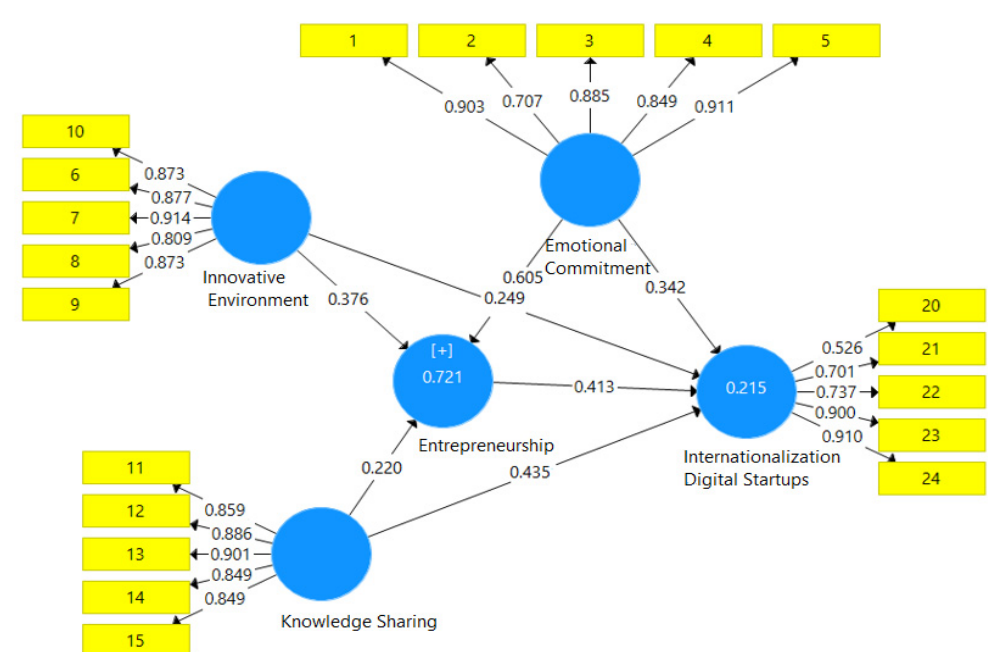
Fig. 3: Model in the case of standard factor loading coefficients